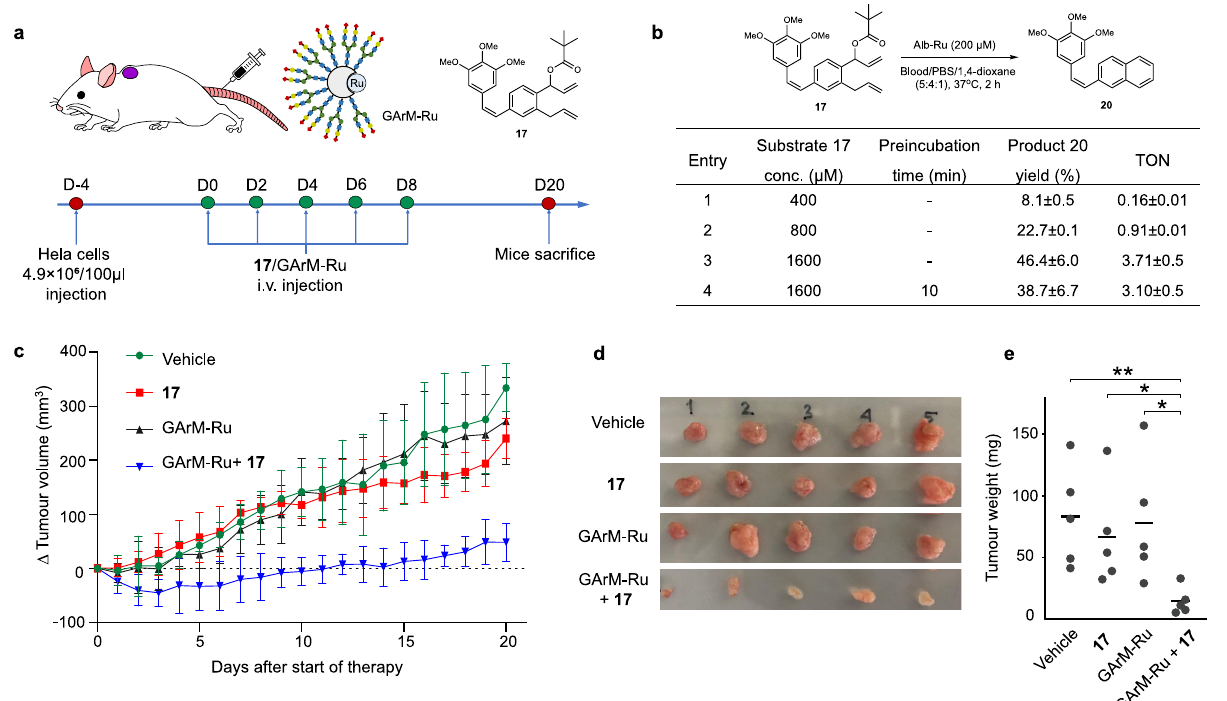
Fig. 6 In vivo synthetic prodrug therapy against HeLa tumor growth in mice. a To highlight the biocatalytic activity of the GArM-Ru complex, the objective was to apply prodrug therapy via intravenous administration to treat subcutaneous xenograft tumors in mice. b Reactivity studies of prodrug 17 with Alb-Ru in mixtures of 5:4:1 blood/PBS/dioxane. Product yield was determined by HPLC analysis. Reactions were performed in triplicate. c Measurements of tumor size (mm 3 ) in mice over time; Tumors were initially implanted in mice and developed over 4 days before therapy. Dosages were applied in 5 injections spread out over 8 days. d Extraction and visual comparison of tumor tissues shows the extent of growth inhibition 20 days after the start of therapy (n = 5). e Comparison of measured tumor burden (via weight) 20 days after the start of therapy (n = 5). P values were determined using a two-tailed Student ’ s t -test. ** P = 0.0067 (Vehicle), * P = 0.0274 (Prodrug 17 ), * P = 0.0243 (GArM-Ru); * P < 0.05, ** P < 0.01, and *** P < 0.001. Data in c are represented as mean value ± SD, n = 5 biologically independent